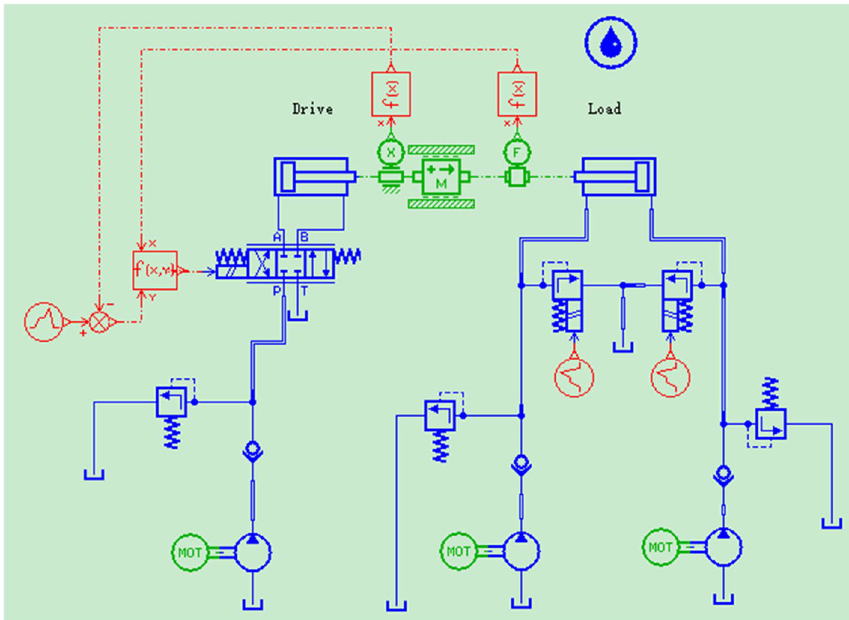
Fig. 3 Simulation model of the